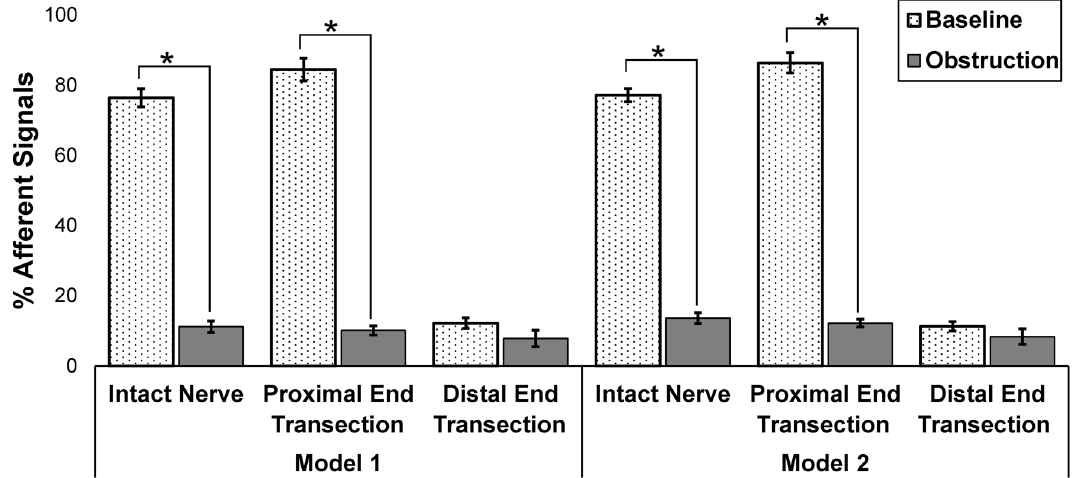
Figure 8. Comparison of the % afferent signals recorded during both baseline and airway obstruction for cases of (1) intact nerve, (2) transection of only the proximal end, and (3) transection of only the distal end. Analysis was performed for model 1 and model 2 classifiers. [*, p value < 0.05 compared to baseline, n =